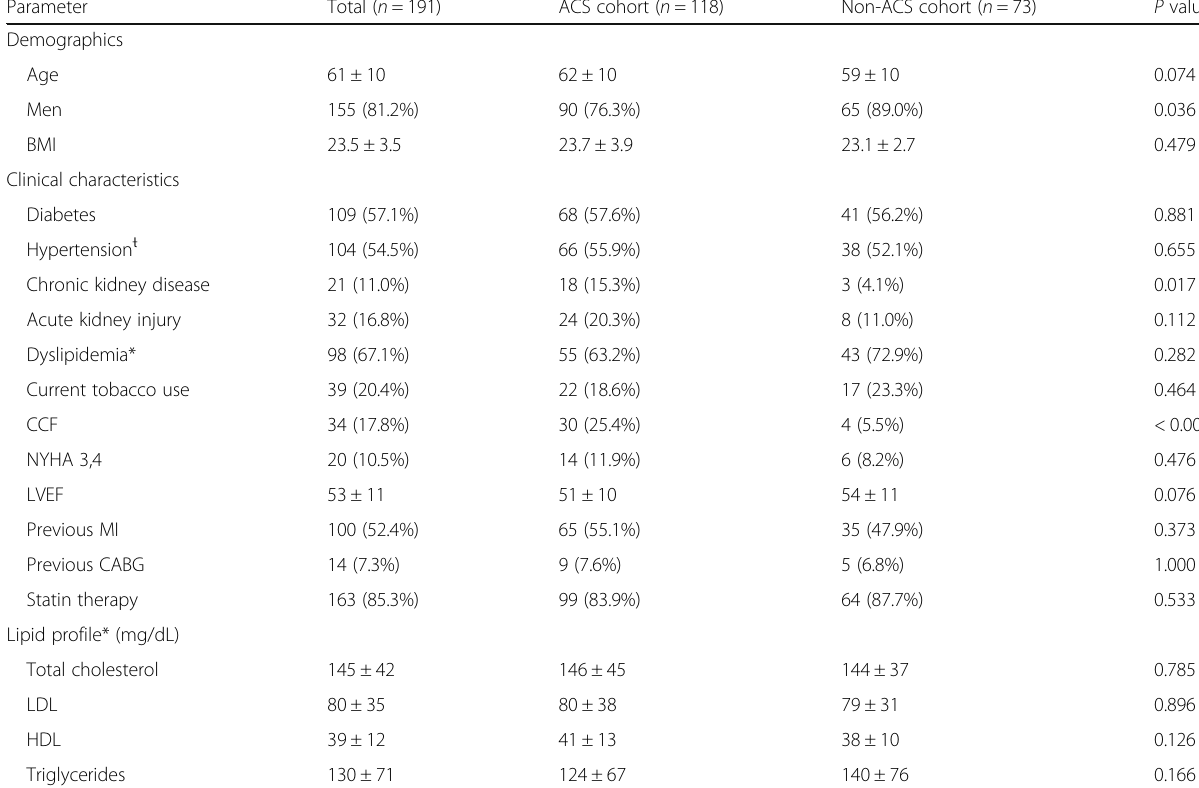
Table 1 Patient characteristics at first clinical ISR presentation Parameter Total ( n =